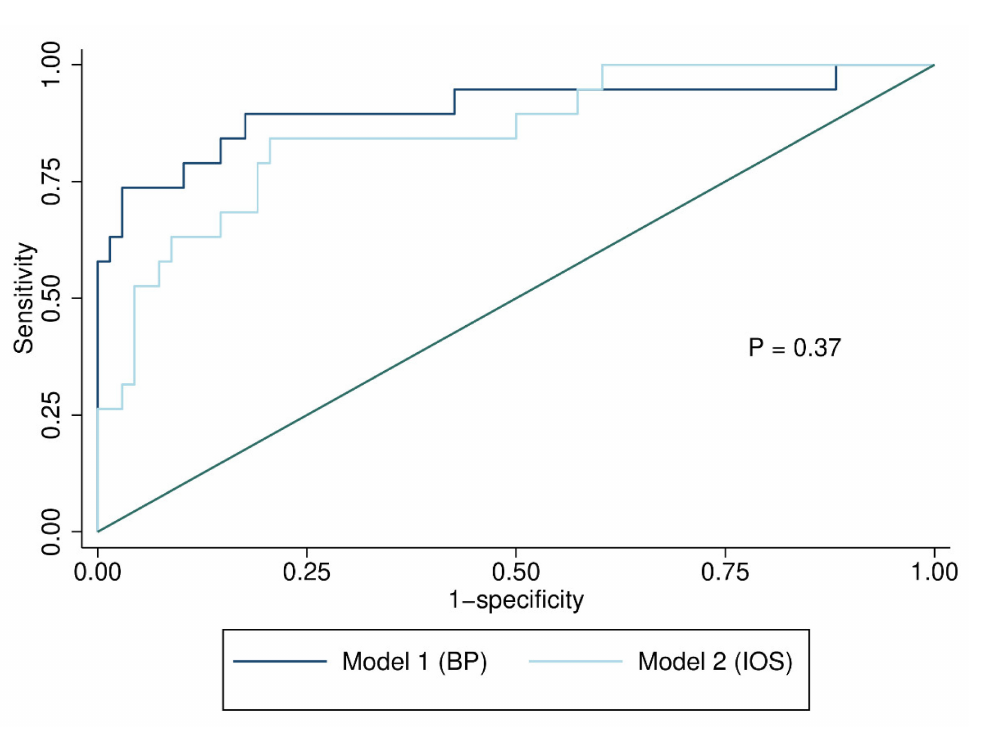
Figure 1. ROC curves for the two logistic regression models of body plethysmography (BP) and impulse oscillometry (IOS)